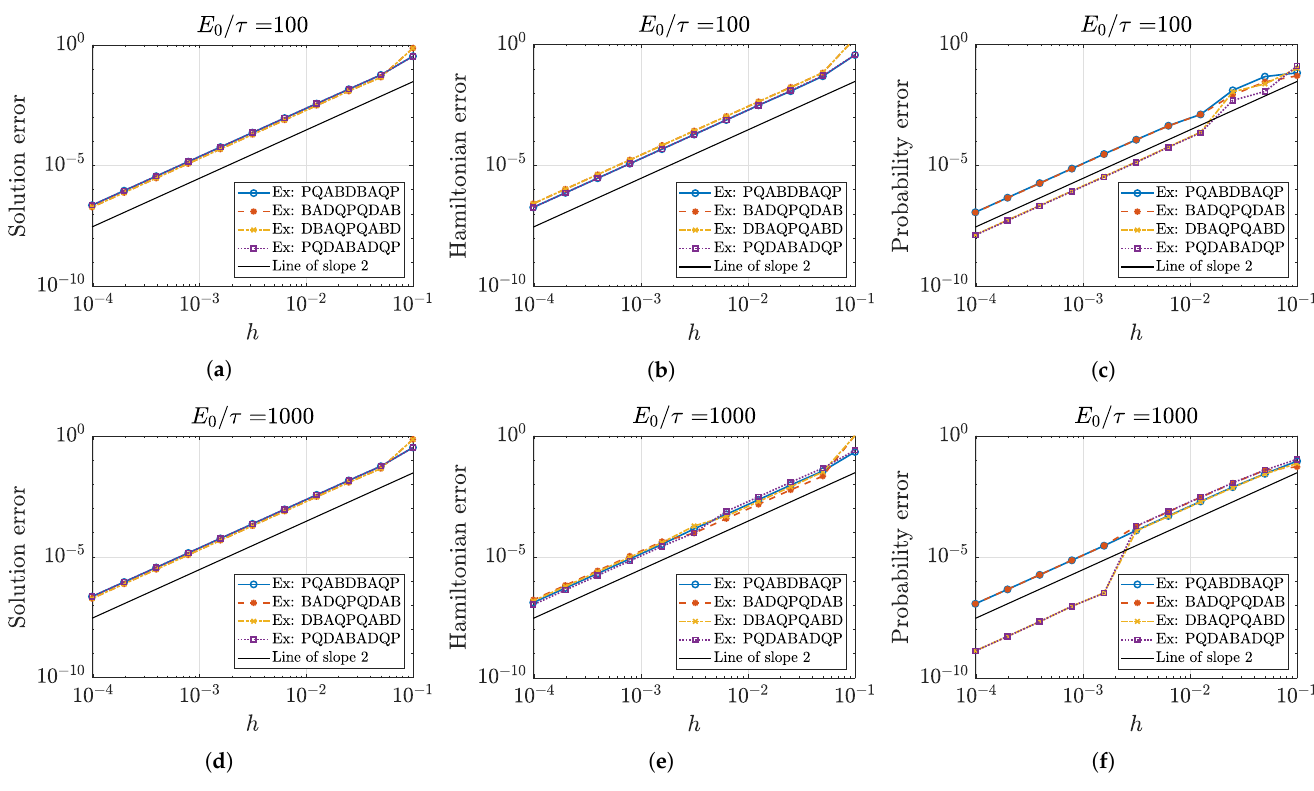
Figure 4. Numerical convergence study of the explicit splitting methods: PQABDBAQP, BADQPQDAB, DBAQPQABD, and PQDABADQP. Top ( a – c ): E 0 / τ = 100. Bottom ( d – f ): E 0 / τ = 1000. Left ( a , d ): maximal absolute error of the solution at t = 1. Middle ( b , e ): maxi- mal relative error of the Hamiltonian (42) for t ∈ [ 0,1 ] . Right ( c , f ): maximal relative error of the total charge probability (16) for t ∈ [ 0,1 ] . The numerical solution of reference is computed with the method PQDABADQP and time step h = 10 − 7 , and with initial conditions given by the patterns (100) and (101), where γ =